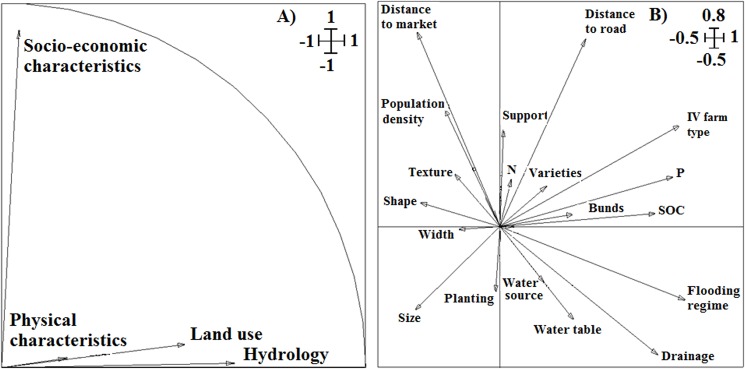
Projection of themes (A) and variables (B) on the factorial axes 1 x 2 of the multiple factorial analyses.